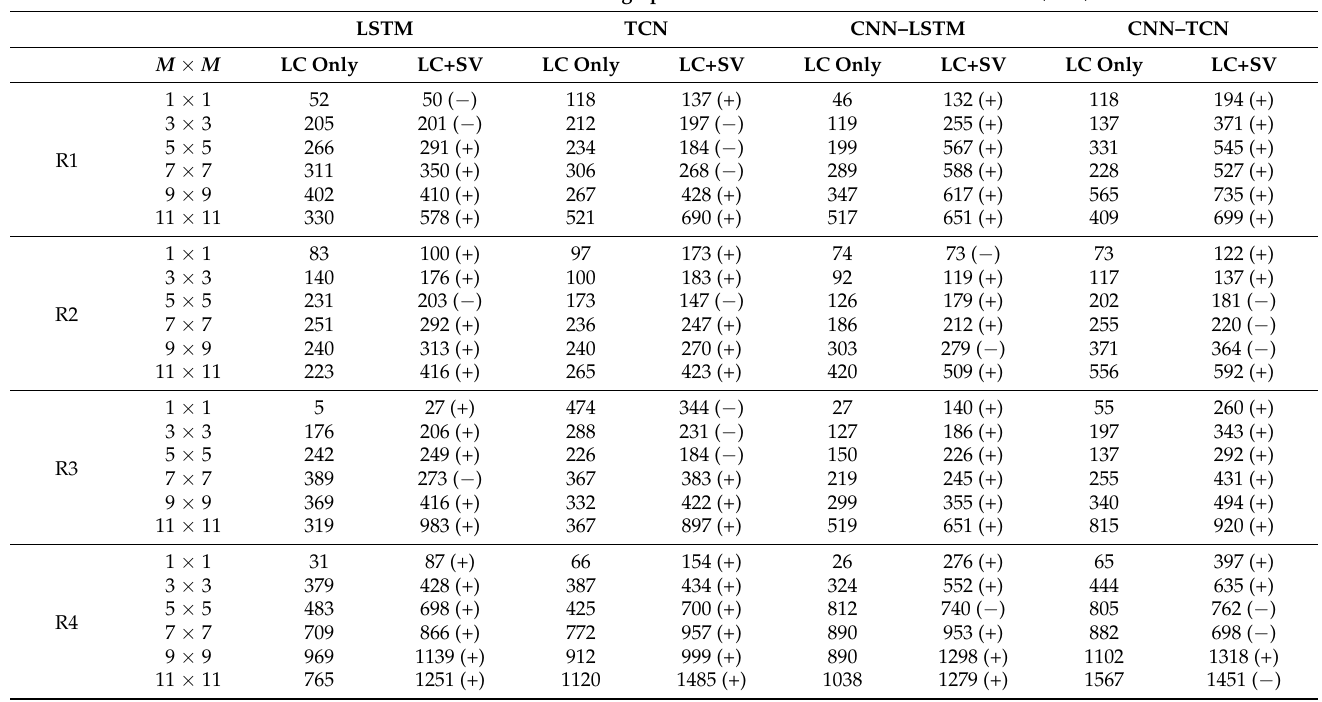
Table 9. Area associated with error due to allocation (EA) obtained for (R1) the Regional District of Bulkley-Nechako, (R2) the Regional District of Central Kootenay, (R3) the Northern Rockies Regional Municipality, and (R4) the Cariboo Regional District. “LC Only” refers to models considering the LC data as the only input (Figure 2), while “LC+SV” refers to models provided the added spatial variables input (Figure 3). ± indicates if LC+SV added or reduced